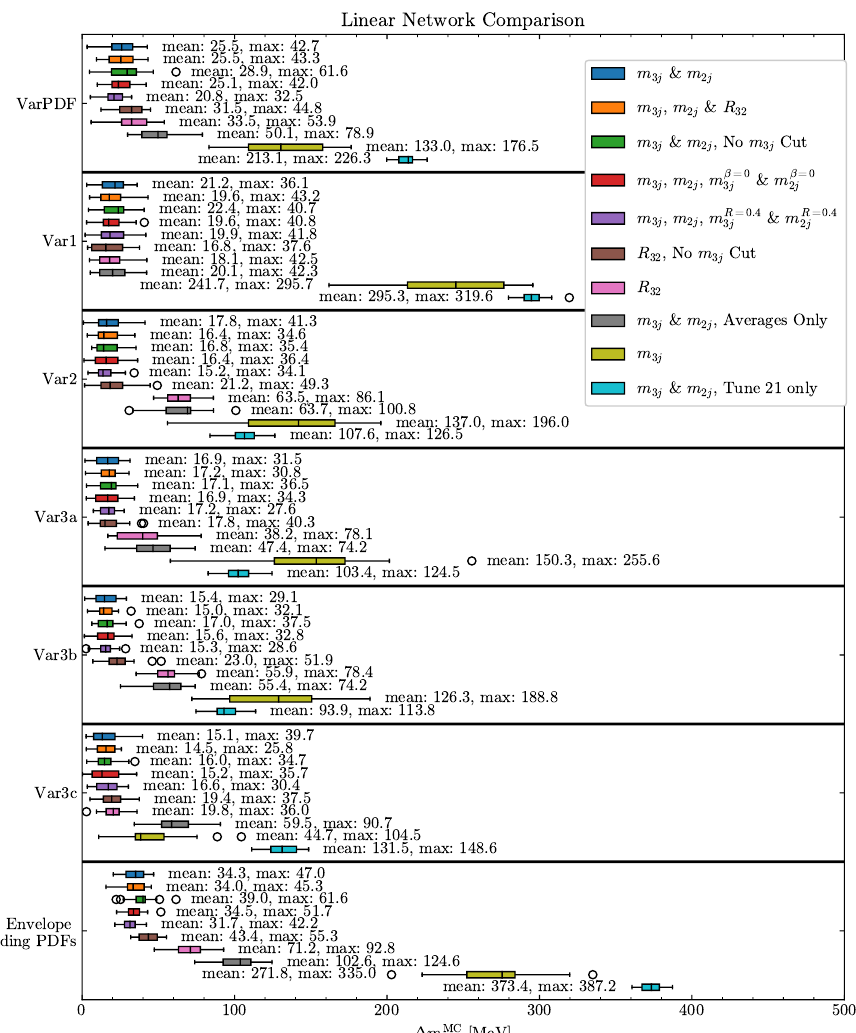
Figure 6. Uncertainties on the top mass linear network fits within each group of variations in the A14 set of tunes, with different observables as inputs. The Total Envelope section contains the envelope of all tunes. For every network displayed (except that trained only on the means of the distributions and the soft drop example), the distributions are sorted by increasing m 3 j . For the soft drop example, the distributions are sorted by m 3 j with β = 0 rather than the original m 3 j . We have restricted m 3 j to between 150–200, except for those networks labeled “No m 3 j cut”.